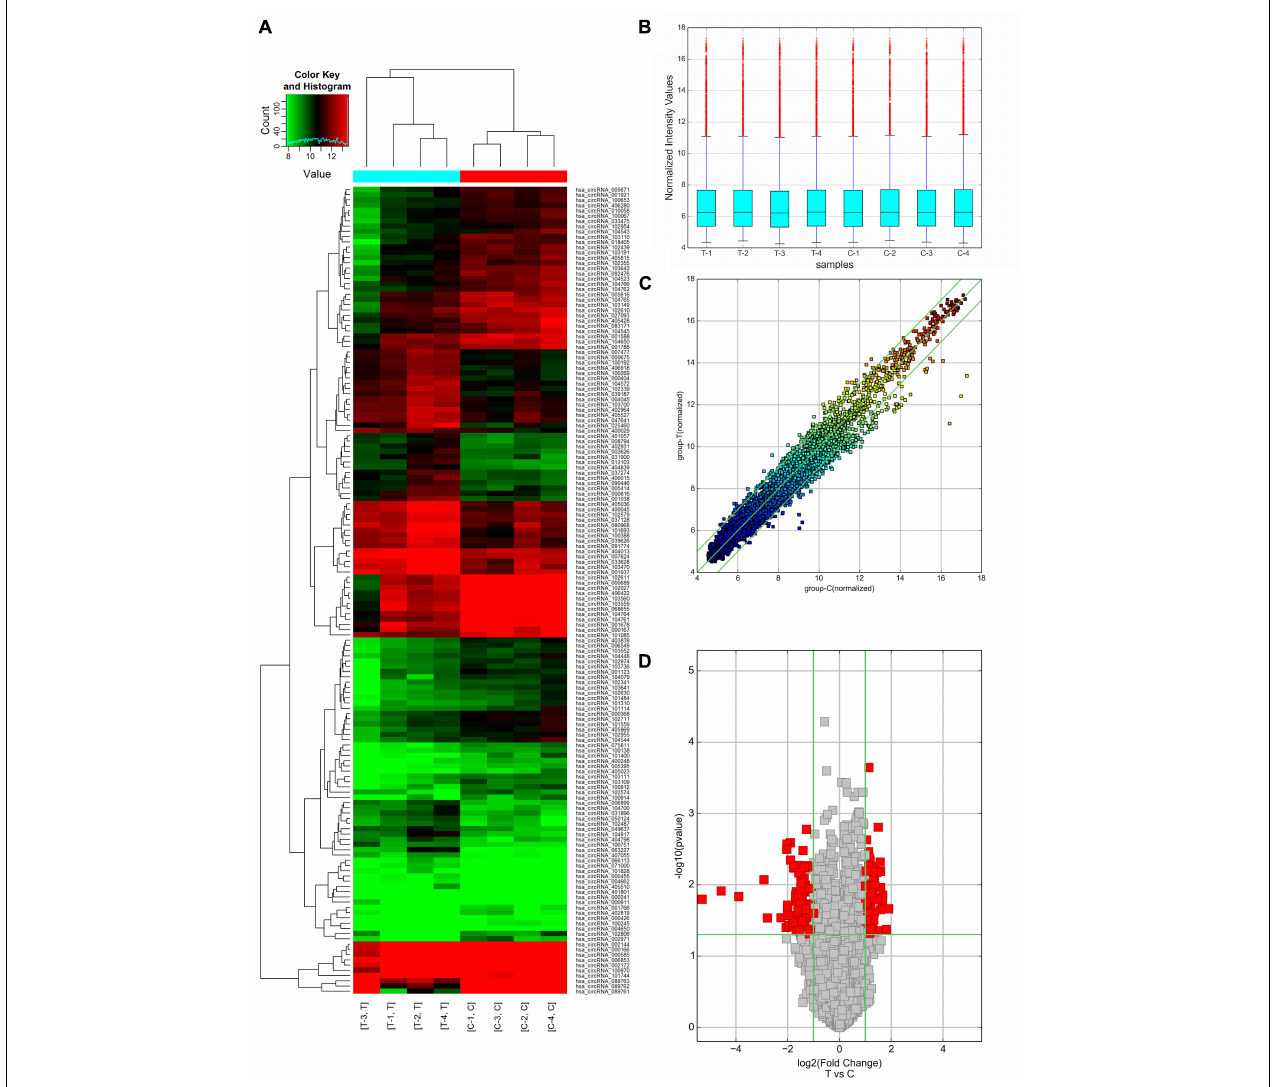
FIGURE 2 | circRNA expression profiles of AMI patients (Group T: T1, T2, T3, T4, and n = 4) and mild coronary artery stenosis patients (Group C: C1, C2, C3, C4, and n = 4) screened by microarray analysis. (A) Heat Map showing a distinguishable expression profile of circRNAs between two groups. Black stands for 0, indicating no change in gene expression; red represents up-regulation, and green represents down-regulation. (B) Boxplot view showed the distribution of normalized expression intensity values for two groups. (C) Scatter plot indicated the variation of circRNA expression in AMI patients ( y -axis) and mild coronary artery stenosis patients ( x -axis). (D) Volcano plots visualizing differential circRNA expression between the two groups. The vertical lines correspond to a 2.0-fold change (FC) (log2 scaled) (up-regulation and down-regulation,